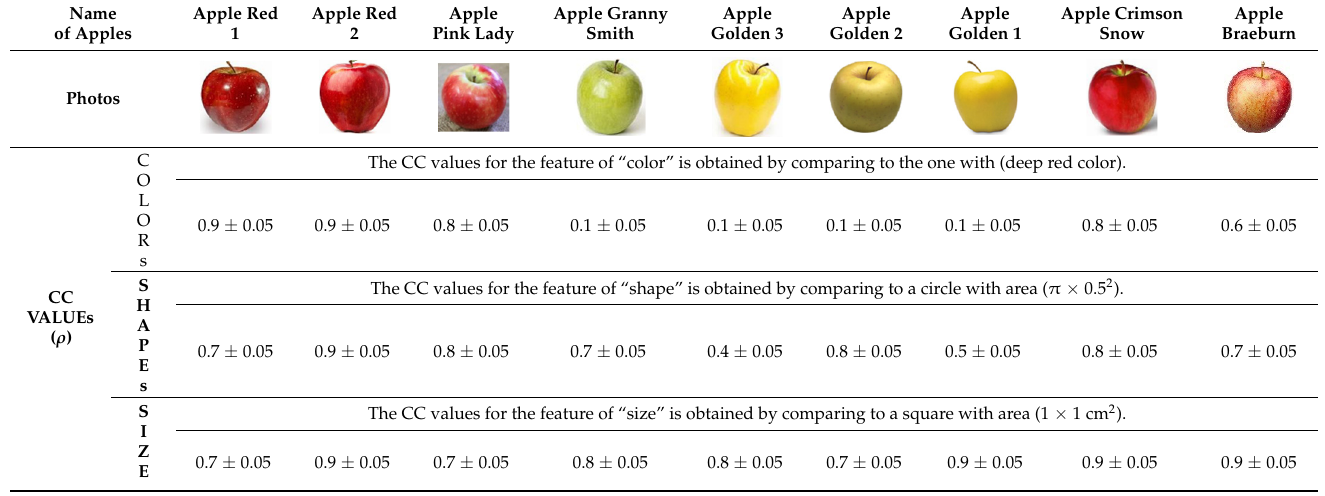
Table 2. Example of CC values for different kinds of apples.